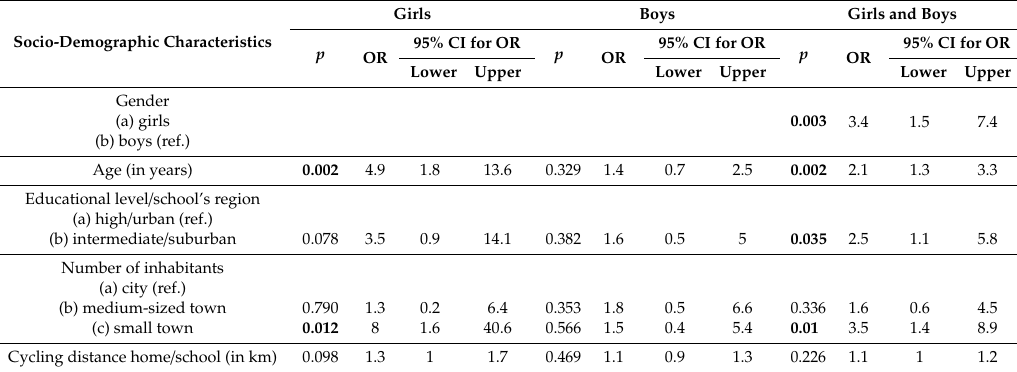
Table A2. Binary Logistic Regressions of Socio-Demographic Characteristics and Habits of Cycling to School based on the Sample of Students.